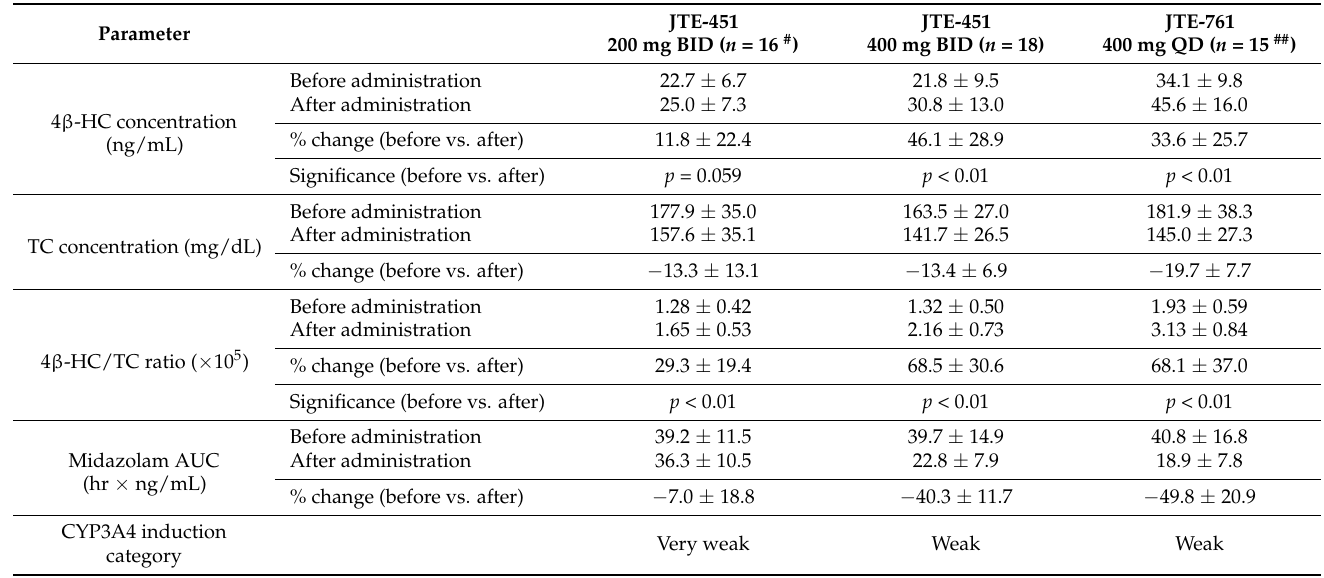
Table 2. Summary of 4 β -HC and TC concentrations, 4 β -HC/TC ratios, the AUC of midazolam, and the CYP3A4 induction category obtained during the clinical DDI